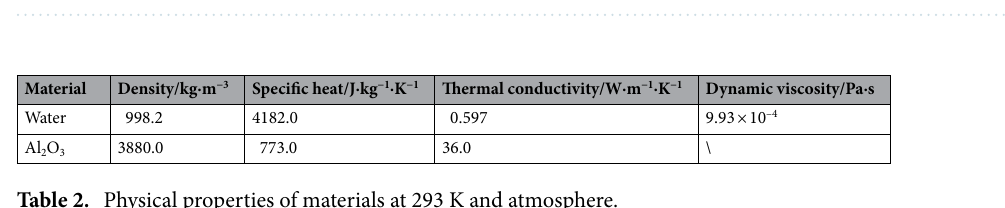
Table 1. The list of geometric constants.